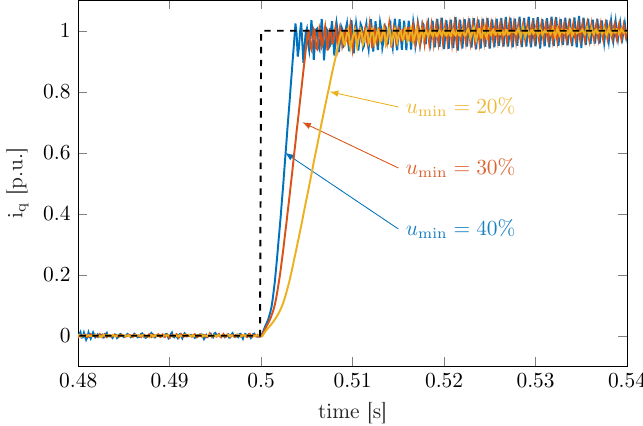
Figure 9. Current behaviours at different u min values at null speed, SynRM 2